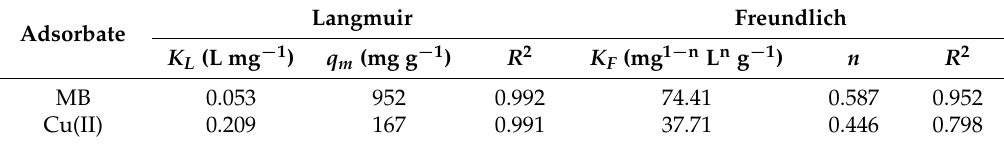
Table 2. Parameters of the Langmuir model and the Freundlich model for the adsorption of MB and